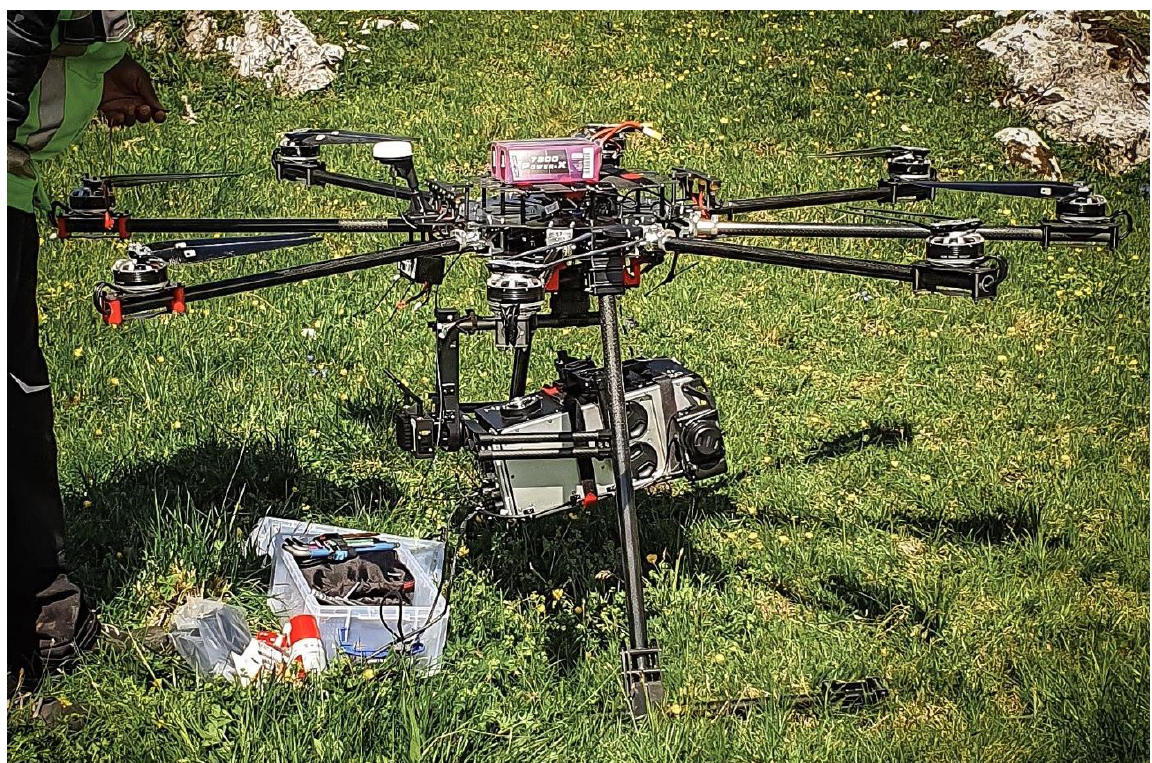
Figure 4. Image of the UAV and Hyspex Mjolnir-VS mounted sideways in the Gremsy gStabi H16 XL gimbal. Lens caps for the three sensors (VS-1240, S-620 and Sony Alpha) can be seen on the right side of the camera.